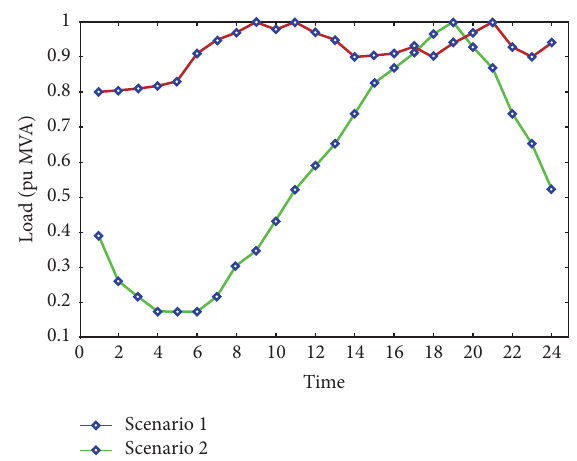
Figure 2: Load variation for